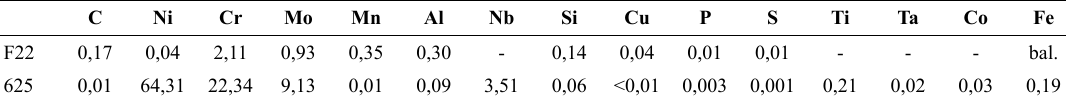
Table 1. Chemical composition (wt%)